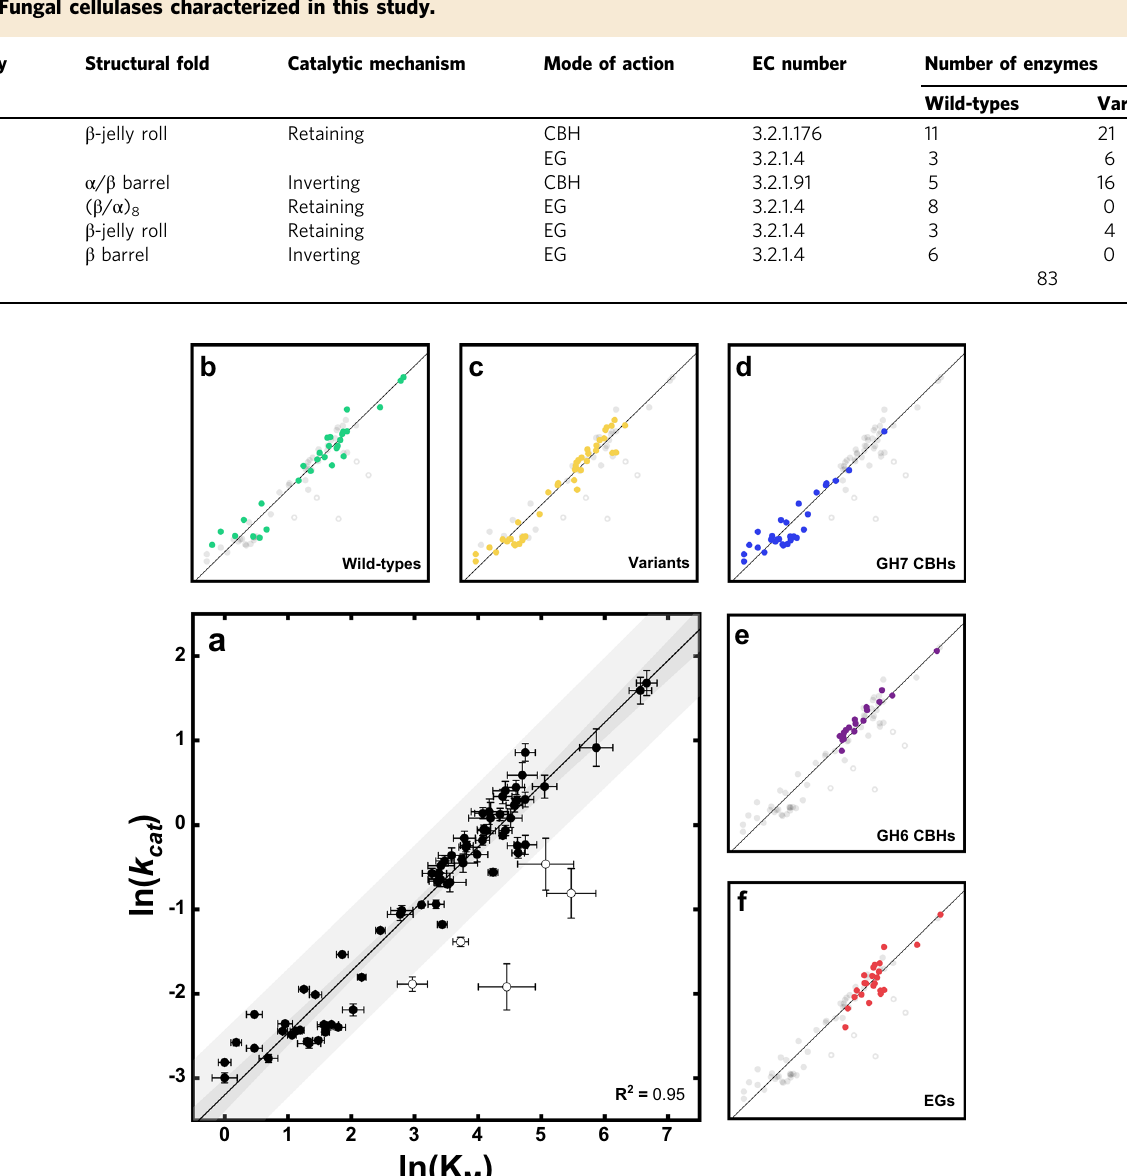
Fig. 2 Correlation plot of ln(K M ) and ln(k cat ). Correlation plot for all investigated enzymes ( a ). The smaller panels highlight data for different classes of enzymes. These are wild type cellulases ( b ), variants ( c ), cellobiohydrolases from GH7 ( d ), cellobiohydrolases from GH6 ( e ), and endoglucanases from family GH7, GH12, and GH45 ( f ). The solid line in all plots derives from linear regression to the experimental data in the main panel ( a ) excluding the outliers (open symbols) identi fi ed as explained in the main text. Bands shown in panel ( a ) are 95% con fi dence band (dark gray) and 95% prediction band (light gray) of the linear regression. Error bars in ( a ) represent standard deviations from MM- fi t (Eq. 2) to